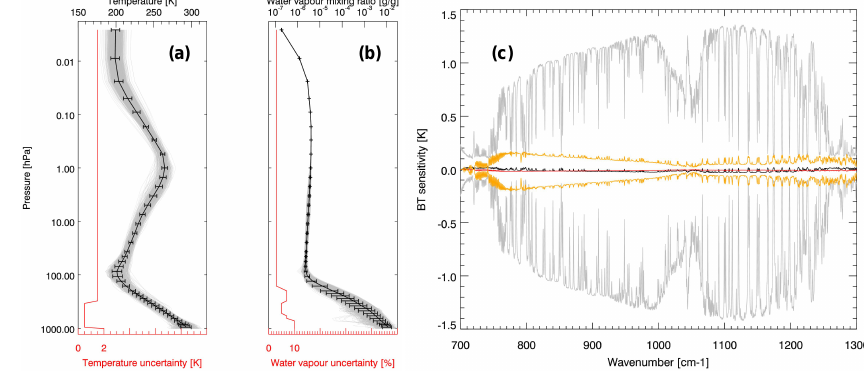
Figure 8. Individual (grey) and average TIGR tropical vertical profiles with standard deviations (black), for temperature (a) and water vapour mixing ratio (b) . The standard deviation of the Gaussian noise used to generate the perturbed profiles is in red in both figures; spectral BT sensitivity for temperature profile (mean differences in black, 1 standard deviation interval in grey) and water vapour profile variability (mean differences in red, 1 standard deviation interval in orange) (c) . See text for further details on how this sensitivity is